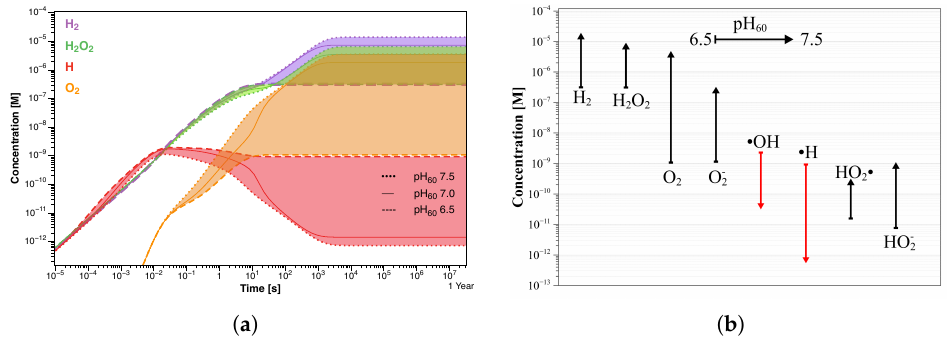
Figure 8. ( a ) Concentration profiles of the main radiolysis products. The colored regions represent the concentration distributions in the initial pH 60 range 6.5–7.5. ( b ) Corresponding concentration trend of the radiolysis products after 1 year of